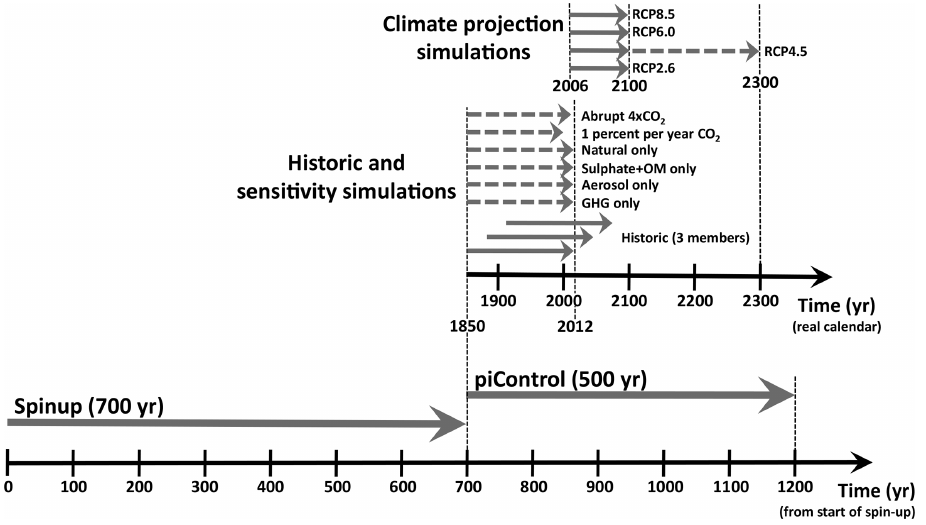
Fig. 1. Schematic of the spin-up and integration procedure followed for the various model experiments with NorESM. See text for a description of the experiments.